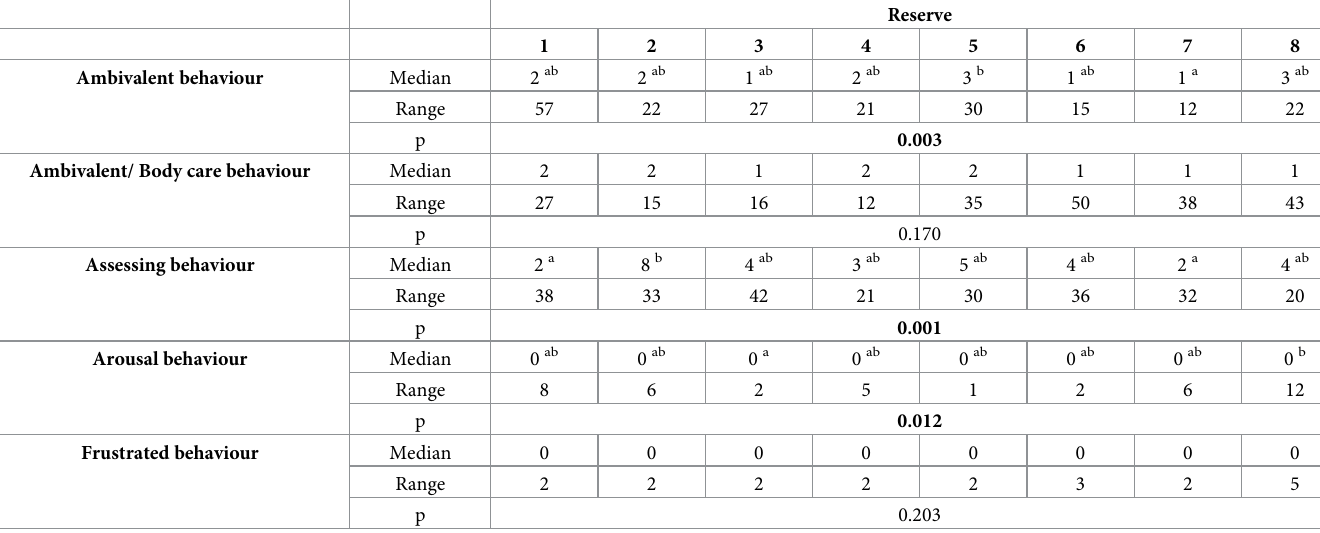
Table 7. The influence of reserve on the frequencies of detailed behaviours (Median (frequency per 10 minutes), Range (maximum value is reported, minimum is 0 for all the data), and the p-value) grouped into five behavioural categories.